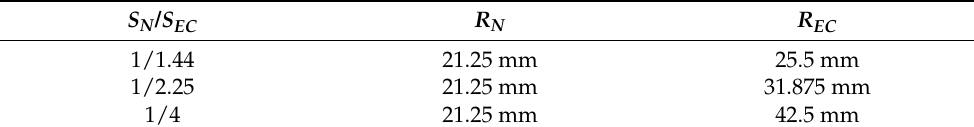
Table 4. Parameters of S N and S EC of the ITECs in Figure 8.